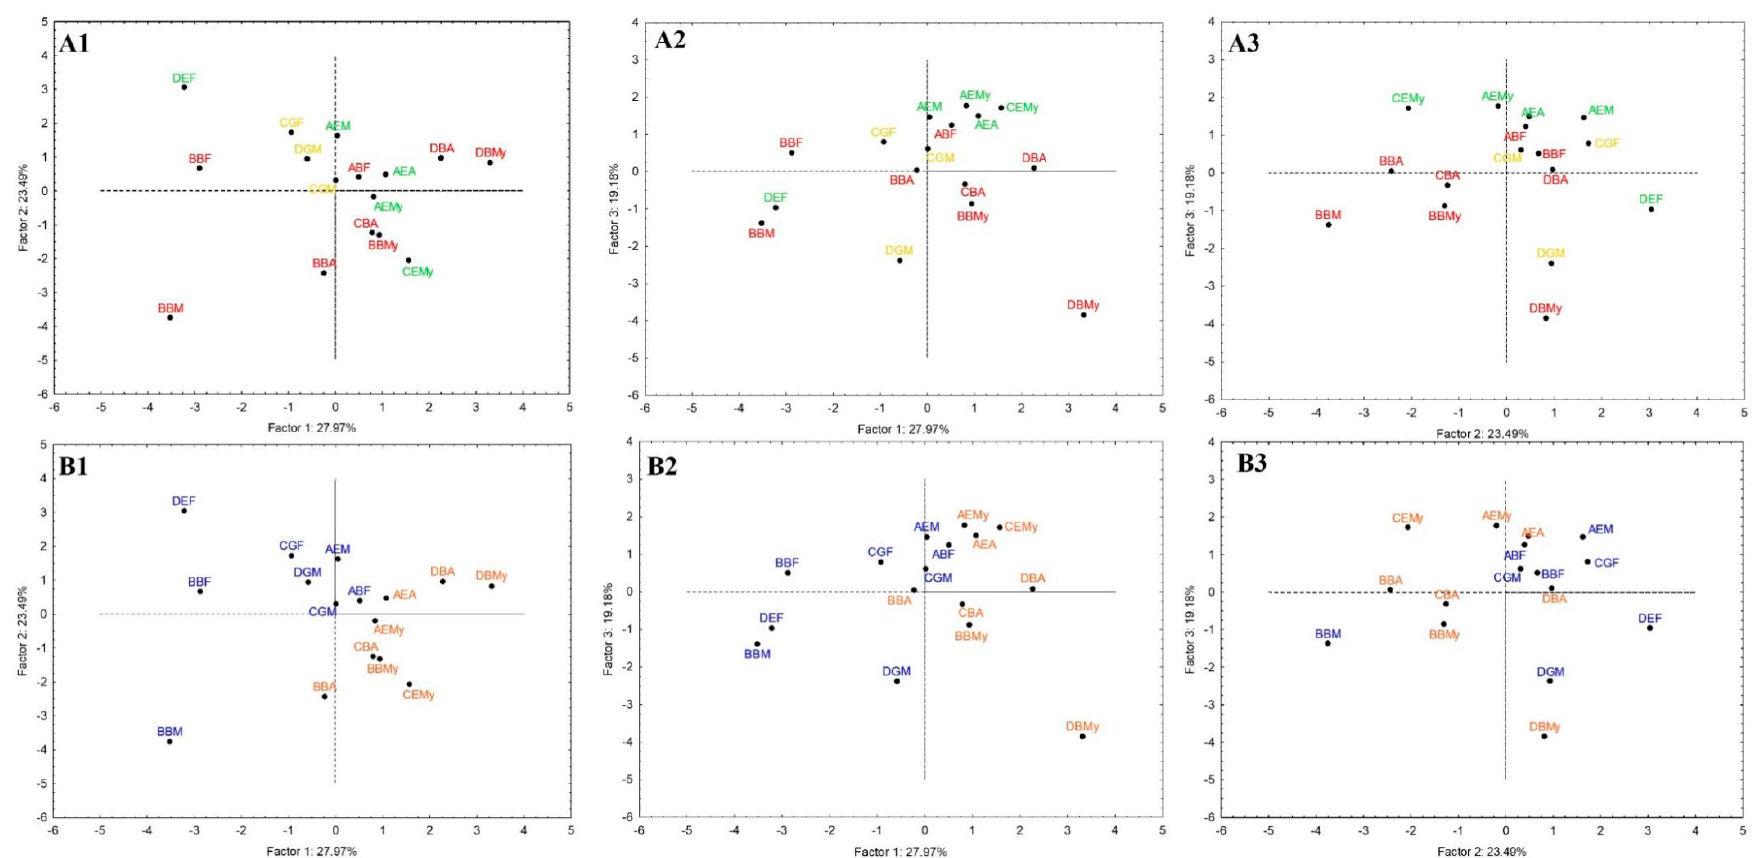
Figure 4. Samples projection of principal component analysis. A: highlighting samples by quality as excellent, good and bad (( A1 ): PC1 vs. PC2; ( A2 ): PC1 vs. PC3 and ( A3 ): PC2 vs. PC3); B: highlighting samples by season, namely, winter and spring (( B1 ): PC1 vs. PC2; ( B2 ): PC1 vs. PC3 and ( B3 ): PC2 vs. PC3). In the sample code, the first letter indicates the dairy (A, B, C, D), the second letter indicates the sensory quality (B-bad, G-good, E-excellent) and the last letter(s) means the month of production (F-February, M-March, A-April